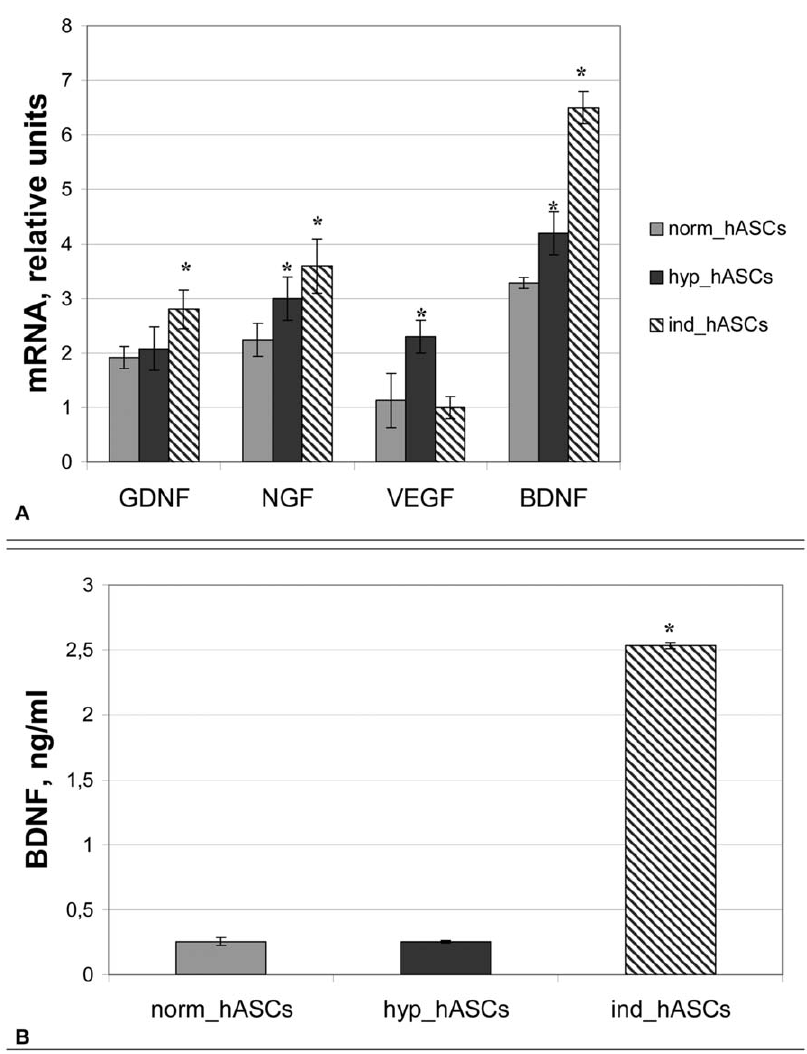
Figure 4. Neurotrophin expressions by hASCs. A.- Real-time PCR analysis of neurotrophin mRNAs expressions in hASCs cultured in standard conditions (norm_hASCs, grey columns), in hypoxia (hyp_hASCs, black columns) or neural differentiation medium (ind_hASCs, hatched columns). B. – ELISA of BDNF level in conditioned medium of hASCs cultured in standard conditions (grey columns), in hypoxia (black columns) or neural differentiation medium (hatched columns). *-p , 0,05 compared to control.